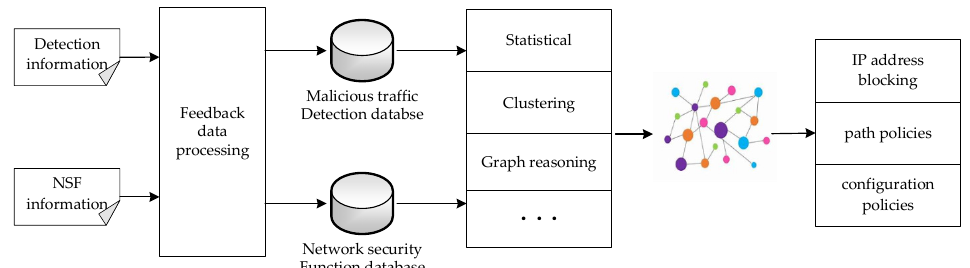
Figure 2. Processing flow of malicious behavior knowledge base block diagram.